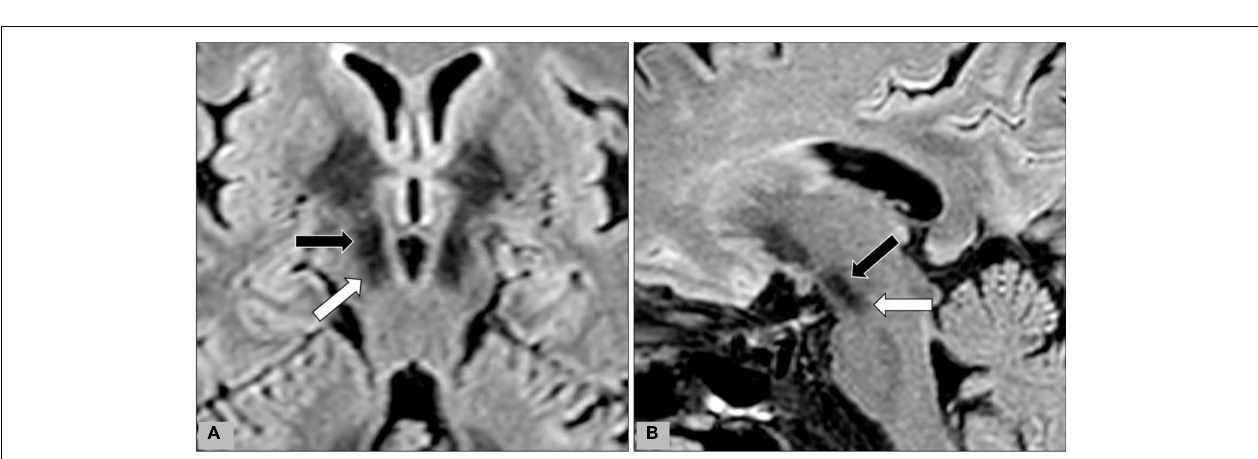
FIGURE 2 | During data-postprocessing, we selected the level of axial image with the optimal visualization of subthalamic nuclei (black arrows) after a review of the T2WI, FLAIR, and SWI images. Oblique coronal (A) and sagittal (B) reformation images were rechecked to ensure that the substantia nigra (white arrow) was not covered on the selected